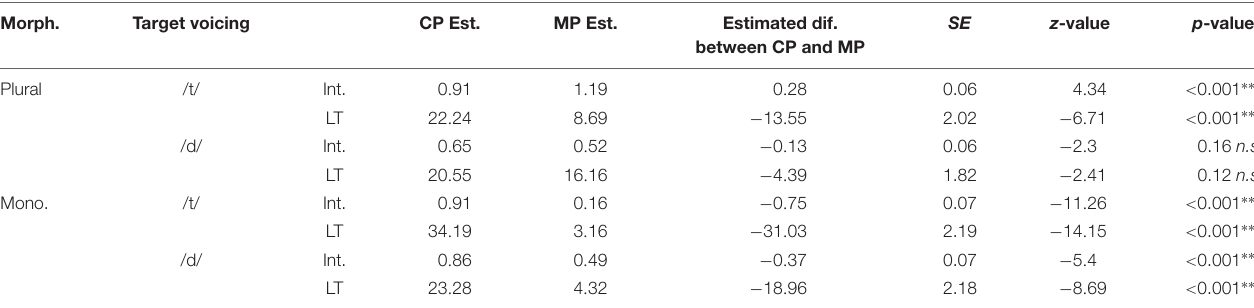
TABLE 6 | Post hoc comparison of the effect of Pronunciation on different word types in Experiment 2. Morph. Target voicing CP